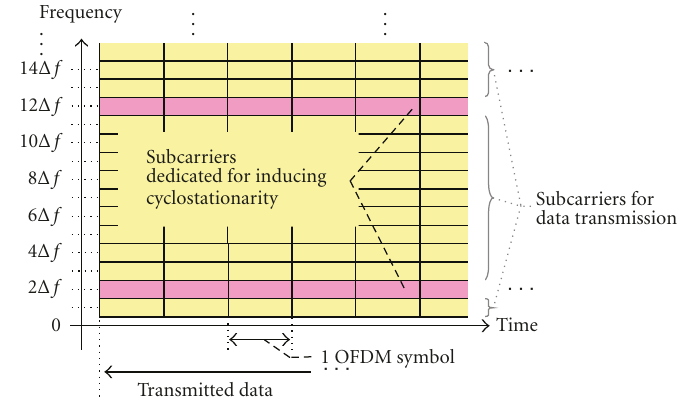
Figure 3: Example of OFDM frame format for Method